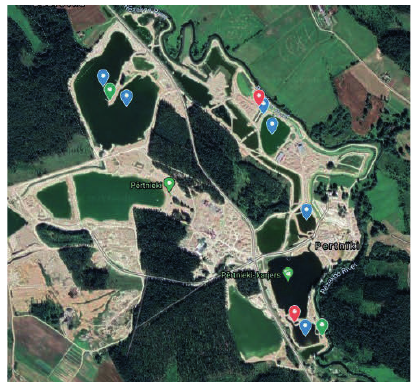
Fig. 6. The locations of nodes and gates in the fishing farm.